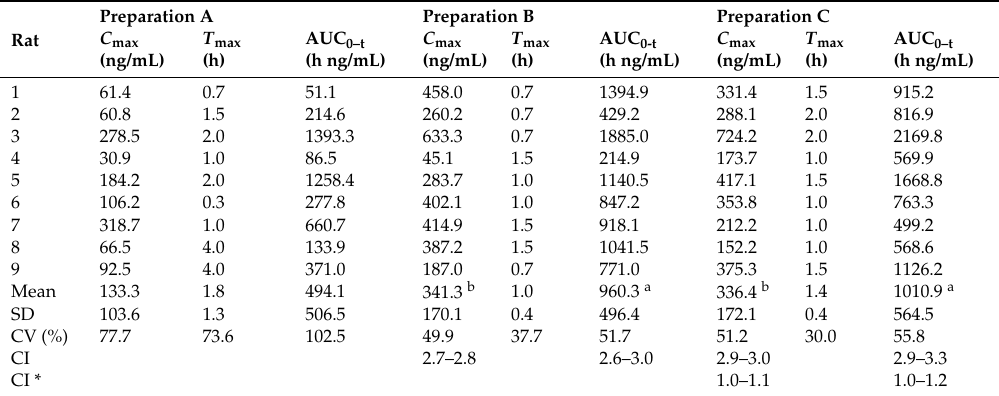
Table 6. Individual values of C max , T max and AUC 0–t and 90% confidence interval for griseofulvin after oral administration of griseofulvin-loaded liposomes prepared using various mechanical dispersion